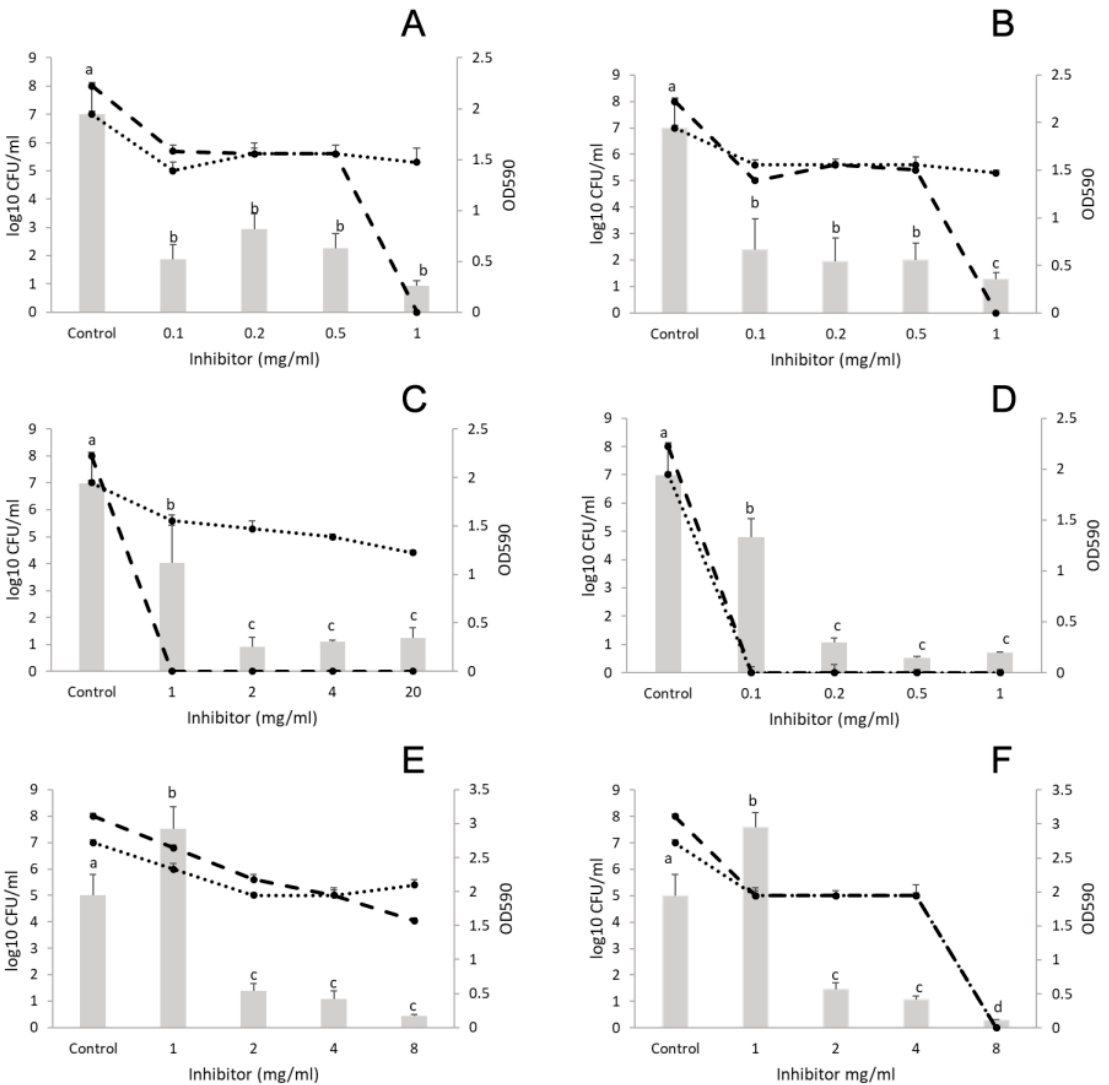
Figure 3. E ff ect of EOs and EO main components on the biofilm formation of Listeria monocytogenes and Pseudomonas putida polymicrobial cultures. ( A ) cinnamon EO, ( B ) trans-cinnamaldehyde, ( C ) thyme EO, ( D ) thymol, ( E ) marjoram EO, and ( F ) terpinen-4-ol. Columns represent the OD 590 values, dashed lines represent cell numbers of L. monocytogenes , and dotted lines cell numbers of P. putida . Results are presented as mean ± standard deviation of six replicates. Di ff erent letters indicate statistically significant di ff erences between columns ( p < 0.05).